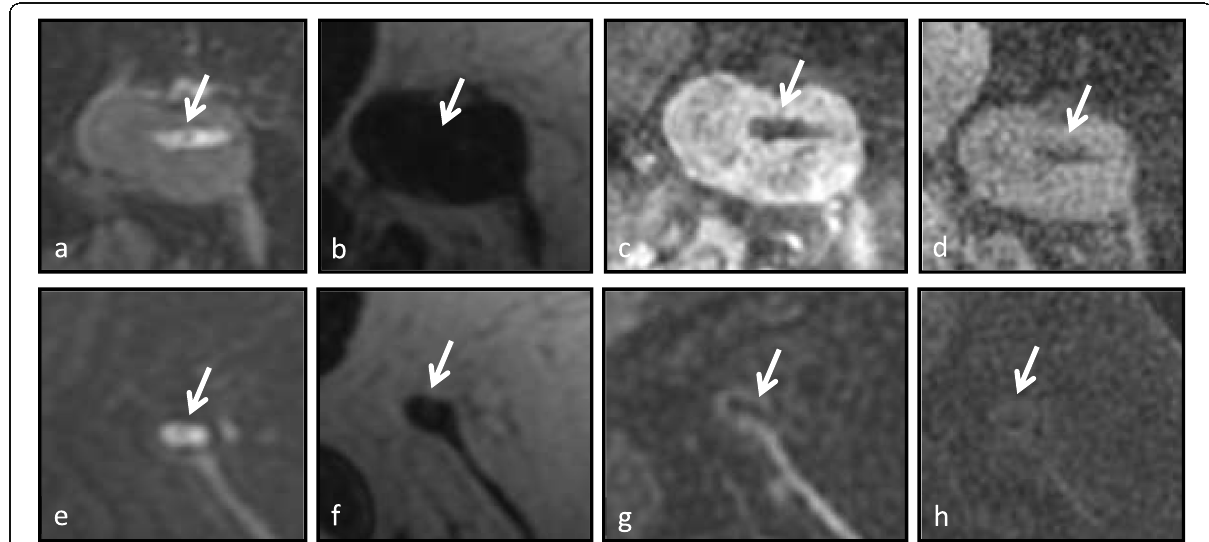
Fig. 3 A 59-year-old female with newly diagnosed left breast invasive ductal carcinoma grade 3 with known metastatic left axillary lymphadenopathy. a – d Initial staging magnetic resonance imaging (MRI) performed 21 days after HydroMARK placement. The marker (arrow)